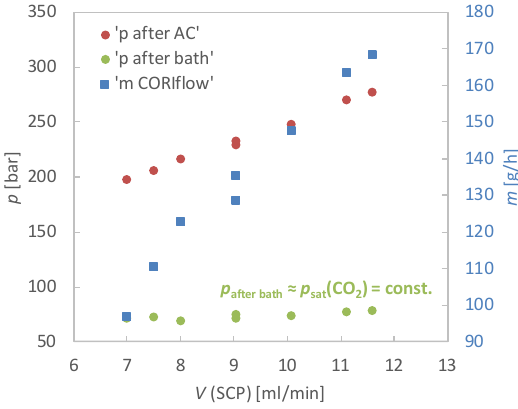
Fig. 5. Inlet pressure ( p after AC), outlet pressure ( p after bath) and mass flow rate through capillary tube CAP 3 ( d = 0.01 mm, L = 7.8 m) depending on flow rate set on the SCP